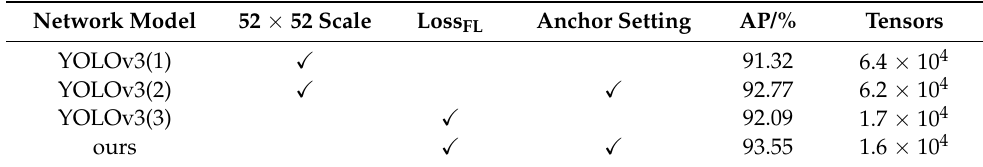
Table 1. Performance comparison of each part of the improved